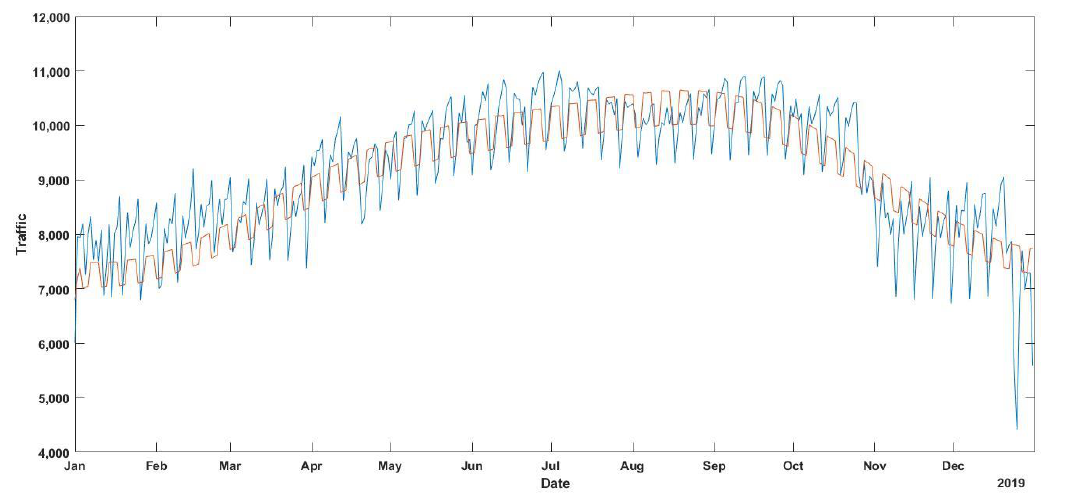
Figure 9. Real Flights 2019 and mean of simulated flights for this